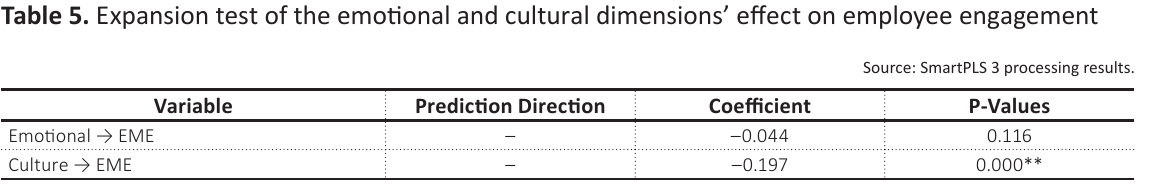
Table 5. Expansion test of the emotional and cultural dimensions’ effect on employee engagement